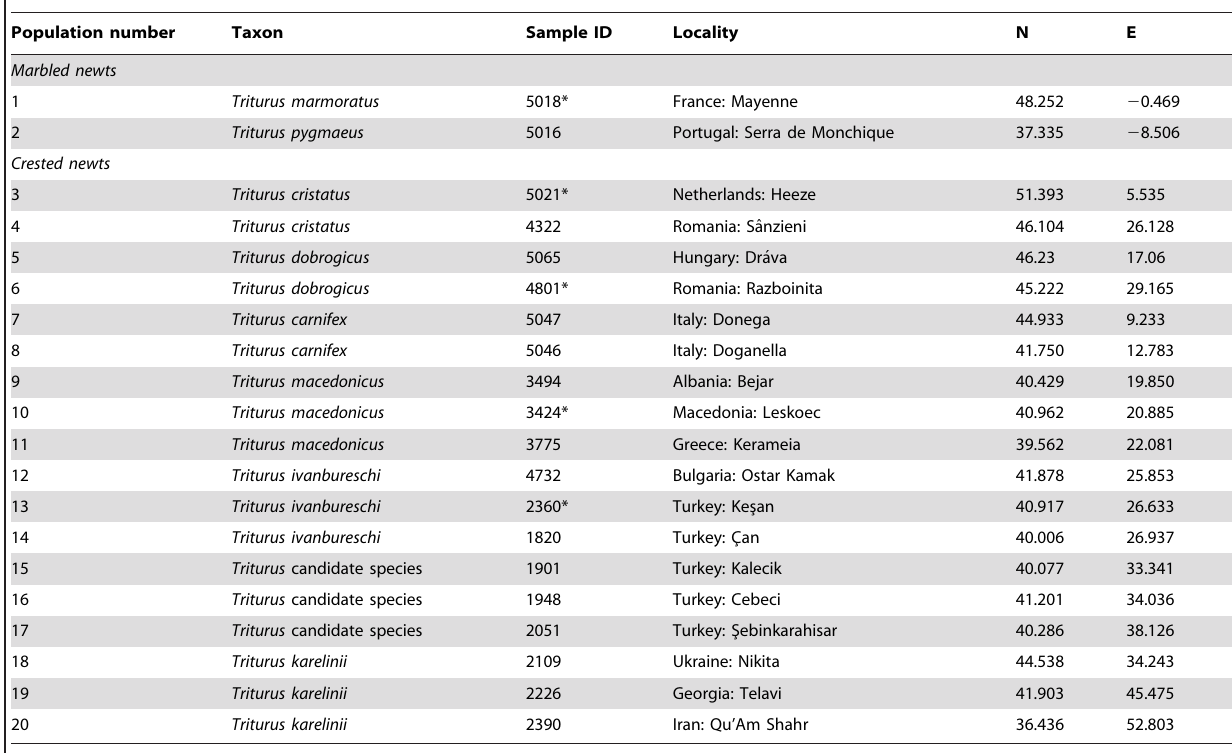
Table 1. Details on Triturus